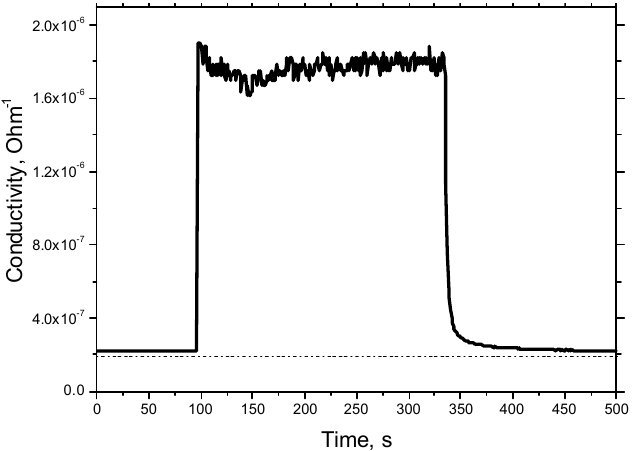
Figure 14. Response/recovery time to 100 ppm of hydrogen in air at working temperature of 450 °C and at relative humidity of 60% (time interval between points—2 s).